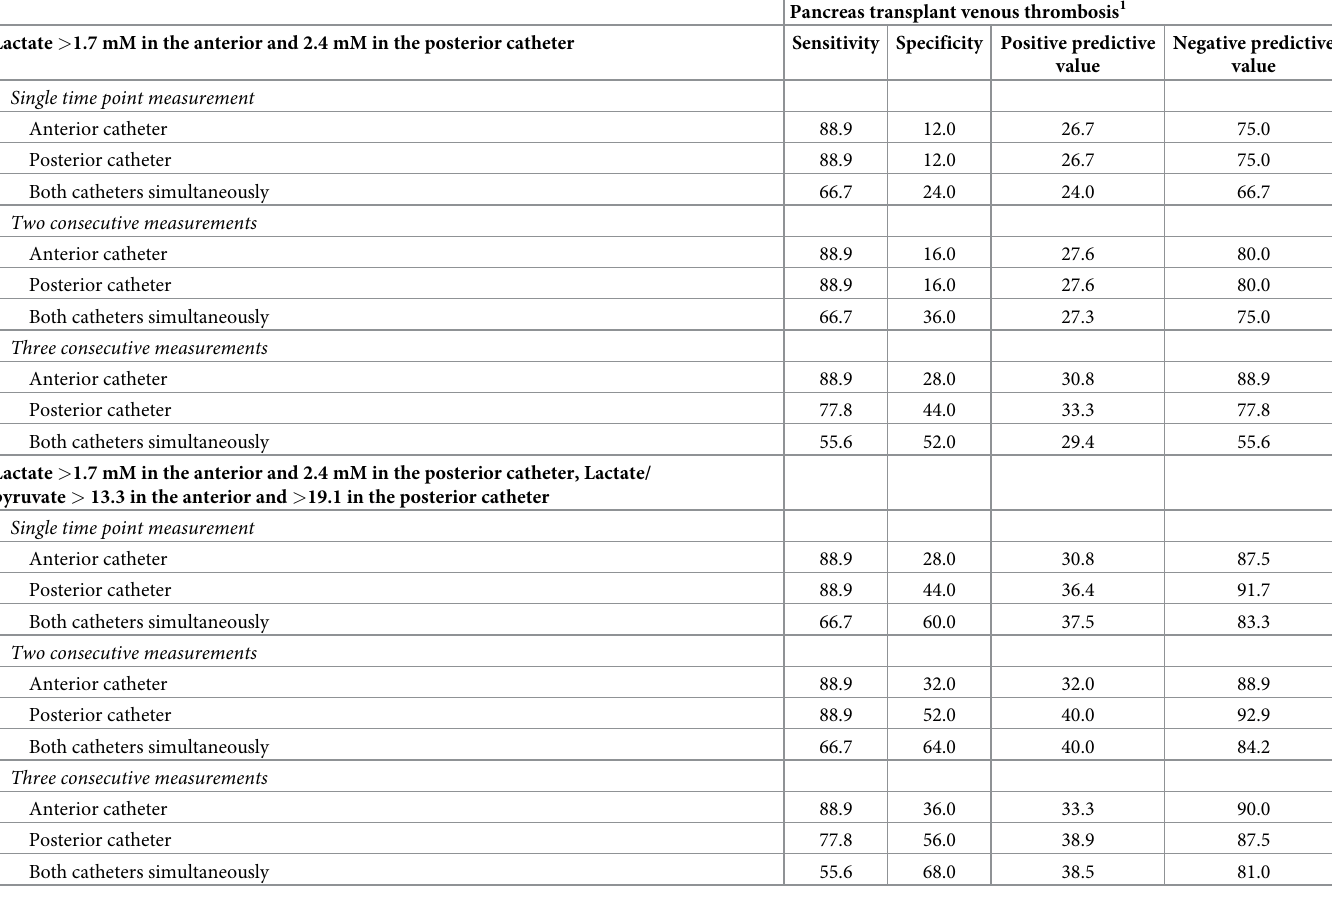
Table 4. Contingency table analyses showing how repeated measurements and catheter placements detected graft venous thrombosis in 34 pancreas transplants of which 9 had venous thrombosis 1